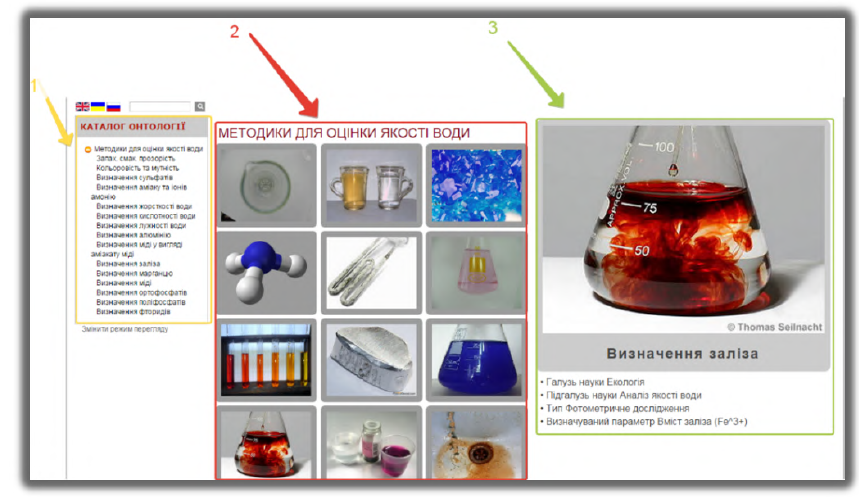
Figure 4: An example of displaying information in the Grafeditor